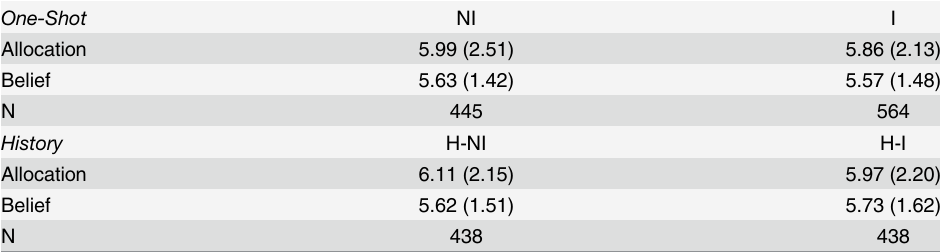
Table 3. Average Allocations and Elicited Beliefs, by Treatment.